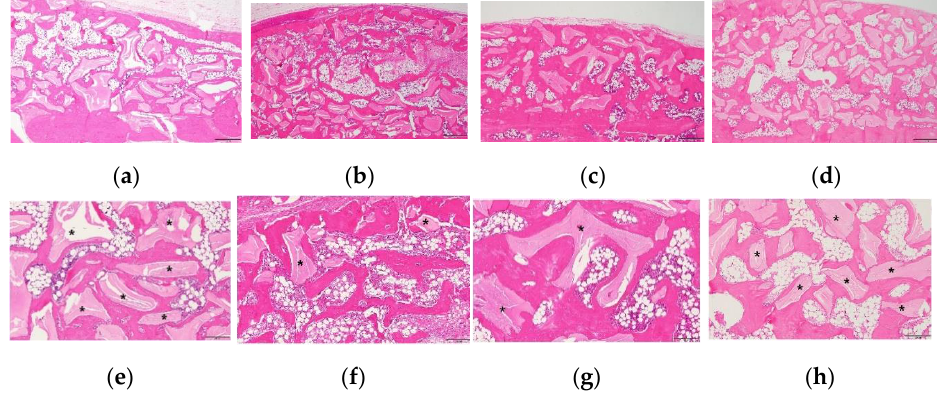
Figure 4. Histological images (hematoxylin and eosin staining) of each group. ( a , e ) 6w particle, ( b , f ) 6w block, ( c , g ) 16w particle, and ( d , h ) 16w block groups. New bone and adipose tissue formation were observed in the particle groups. Large amounts of adipose tissue formation are visible in the central area of bone graft material in the block groups. Panels e–h represent higher magnification of Panels a–d, respectively. Black asterisks = bone scaffold (( a – d ); original magnification 40×, bar = 500 µm, ( e – h ); original magnification 100×, bar = 200 µm).